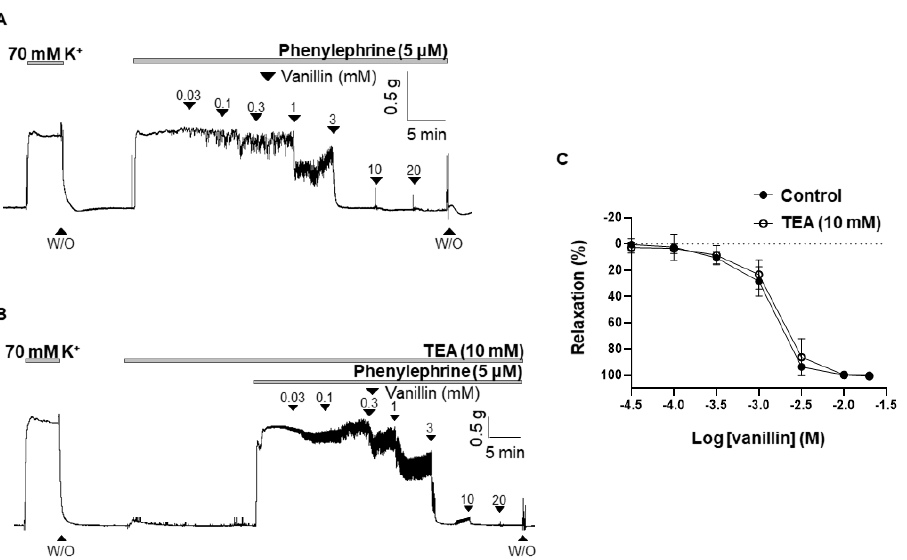
Figure 4. Effect of a K + channel blocker on vanillin-induced vasodilation. Effects of vanillin on the pre-contracted arteries with PE (5 µM) in the absence of TEA ( A ) and in the presence of TEA ( B ). Statistical analysis of the relaxation response of vanillin in the presence of TEA ( C ). Relaxation of arteries is expressed as the percentage of the contraction induced by PE (5 µM). Mean ± SD ( n = 7). (TEA: tetraethylammonium; W/O: wash out).